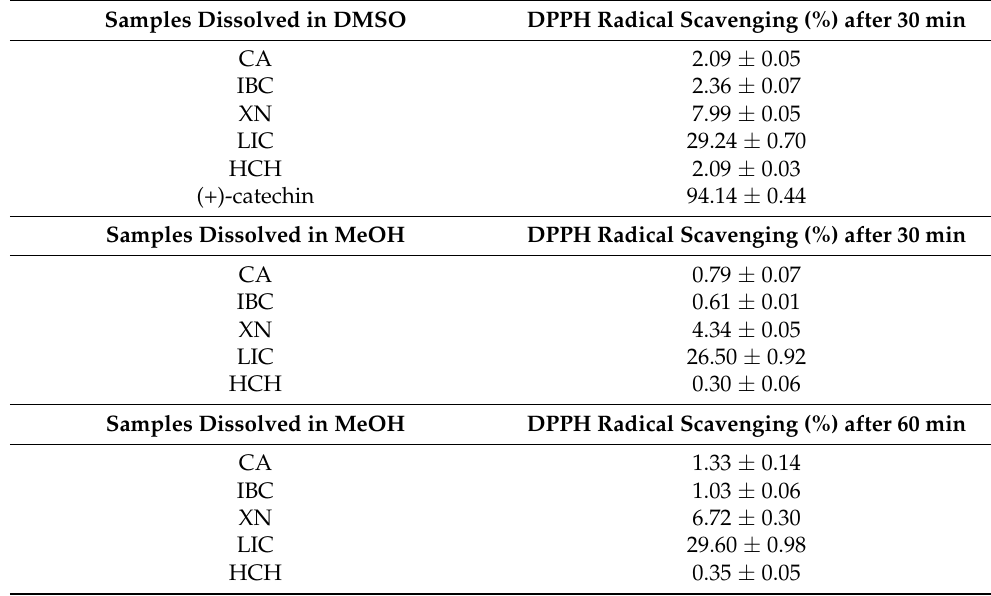
Table 3. DPPH radical-scavenging activity of